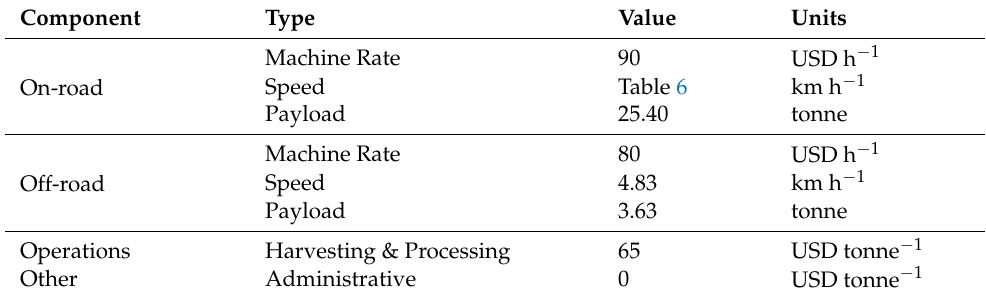
Table 5. Cost components used to convert travel time into cost. Tonne mass units are presented as bone dry.